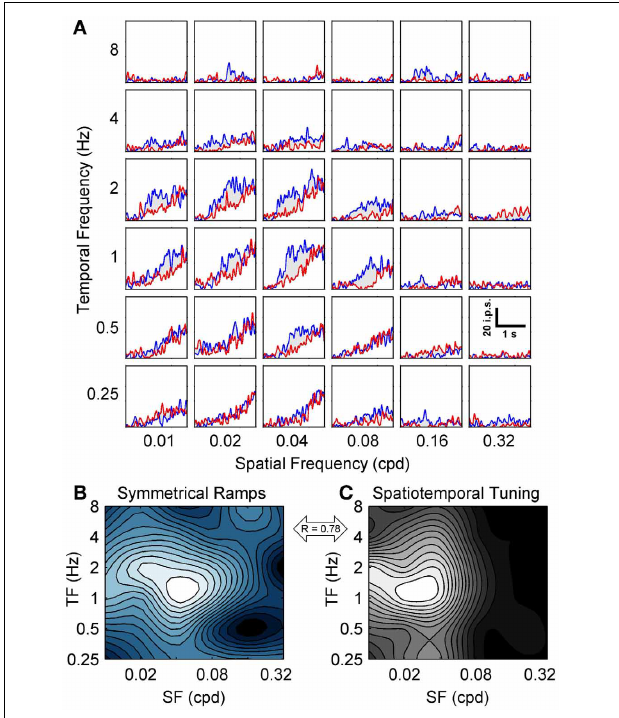
FIGURE 4 | Spatiotemporal specificity of contrast ramp adaptation. The grid of SDFs in (A) show the hysteresis induced in a sample neuron by symmetrical contrast ramps of varying TFs (rows) and SFs (columns). Each SDF follows a similar format to Figure 3B , with responses to the rising phase of the contrast ramp shown in blue and responses to the falling phase shown in red. A scale bar depicting time vs. impulses per second (ips) is shown in the lower right (0.32cpd and 0.5Hz). The spatiotemporal pattern of hysteresis for the sample neuron is represented as a blue-tinted contour plot in (B) , with larger mean differences between the rising and falling phase responses shown as more desaturated hues (see Results). For comparison, the spatiotemporal tuning of the sample neuron is shown in (C) as a grayscale contour plot, and the correlation between the two contour plots is indicated (double-headed arrow). For both contour plots SF is on the abscissa and TF in on the ordinate.